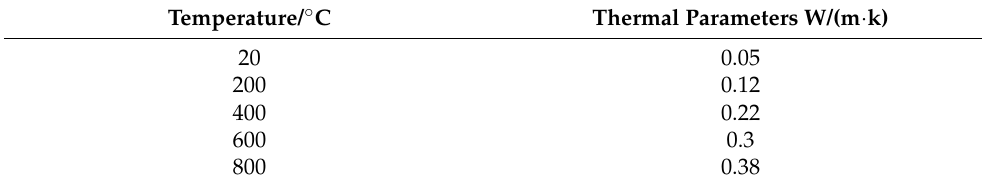
Table 4. Thermal parameters of high-silica needled felt.